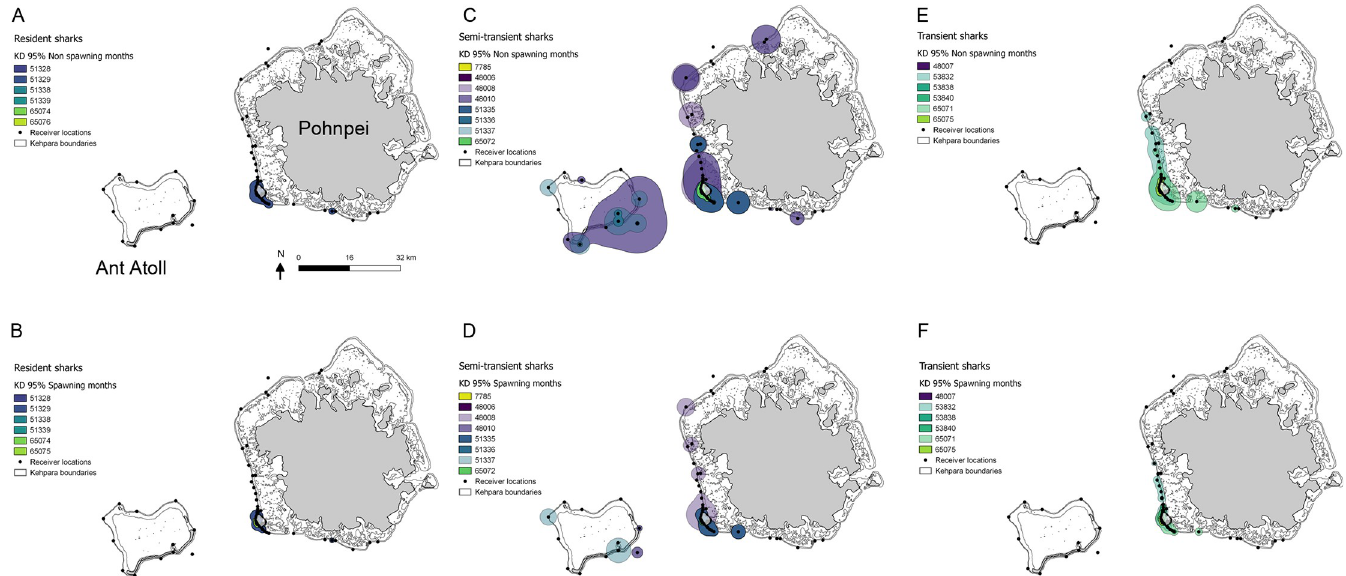
Fig 4. Shark activity space. Activity spaces for 20 female grey reef sharks calculated as 95% Kernel density (KD) utilization for A) resident sharks overall; B) resident sharks during grouper spawning months; C) semi-transient sharks overall; D) semi-transient sharks during grouper spawning months; E) transient sharks overall; and F) transient sharks during grouper spawning months.